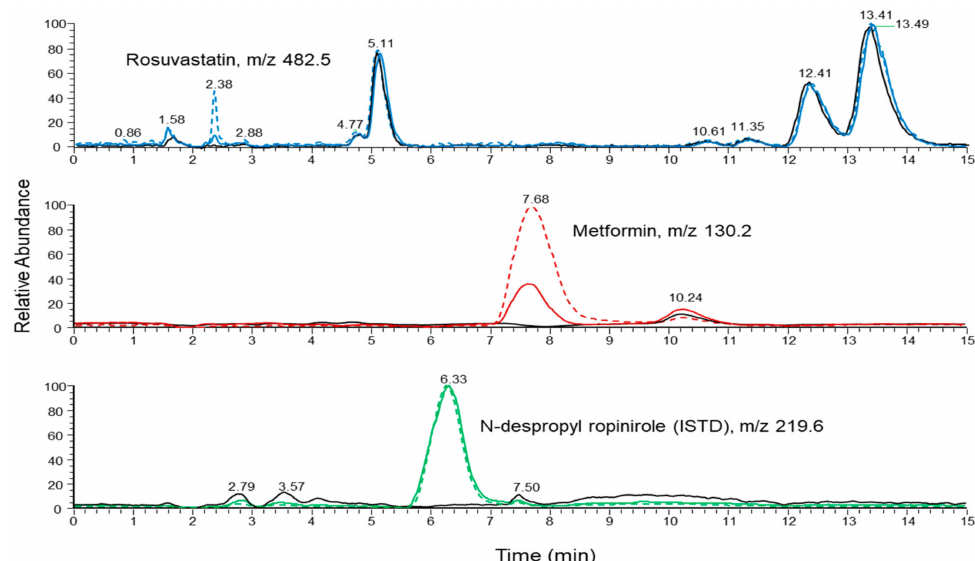
Figure 4. Ion chromatogram (SIM mode) of a blank human plasma sample (black line) overlaid with ion chromatograms (SIM mode) of calibration spiked plasma samples at 2 ng mL − 1 (solid line) and 20 ng mL − 1 (dashed line) of rosuvastatin (blue line), 100 ng mL − 1 (solid line) and 1000 ng mL − 1 (dashed line) of metformin (red line) and 190 ng mL − 1 of ISTD (green